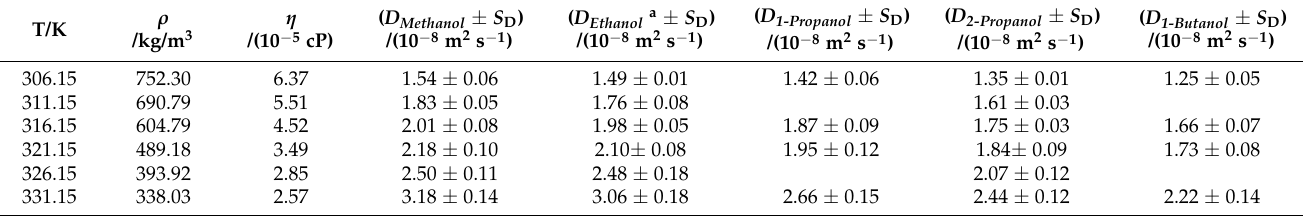
Table 1. Measured diffusion coefficients D for short chain alcohols in supercritical CO 2 at pressure p = 10.5 MPa, calculated density ρ and viscosity η [18] for supercritical CO 2 at different temperatures from 306.15 to 331.15